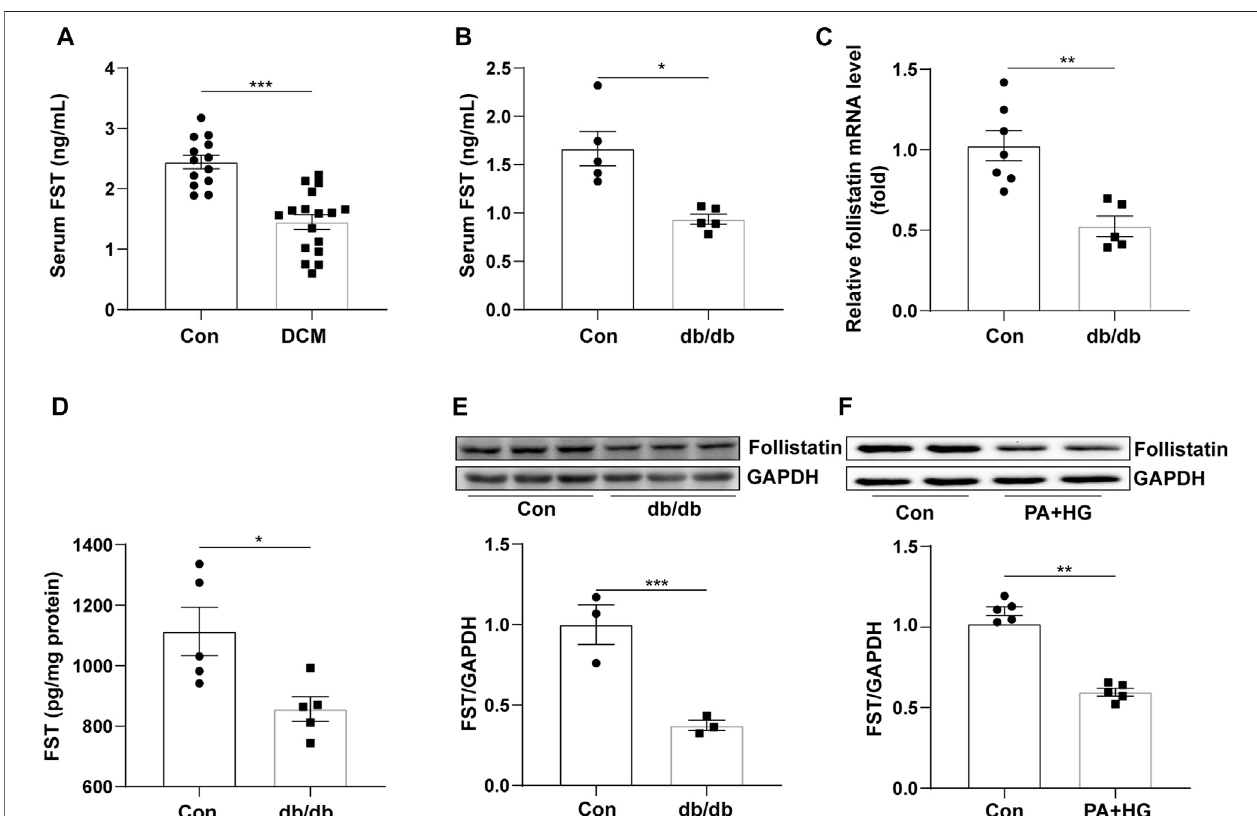
FIGURE1| RelationshipbetweenFSTanddiabeticcardiomyopathy.SerumlevelsofFSTinhealthycontrolsandpatientswithdiabeticcardiomyopathy[ (A) , n ≥ 13]. Levels of FST in serum [ (B) , n (cid:1) 5] and heart tissues of controls and db/db mice [ (C, D) , n ≥ 5]. Protein levels of FST in control and db/db mice [ (E) , n (cid:1) 3)]. Expression of FST in AC16 cells with or without HG + PA treatment [ (F) , n (cid:1) 5]. * p < 0.05; ** p < 0.01; *** p < 0.001.